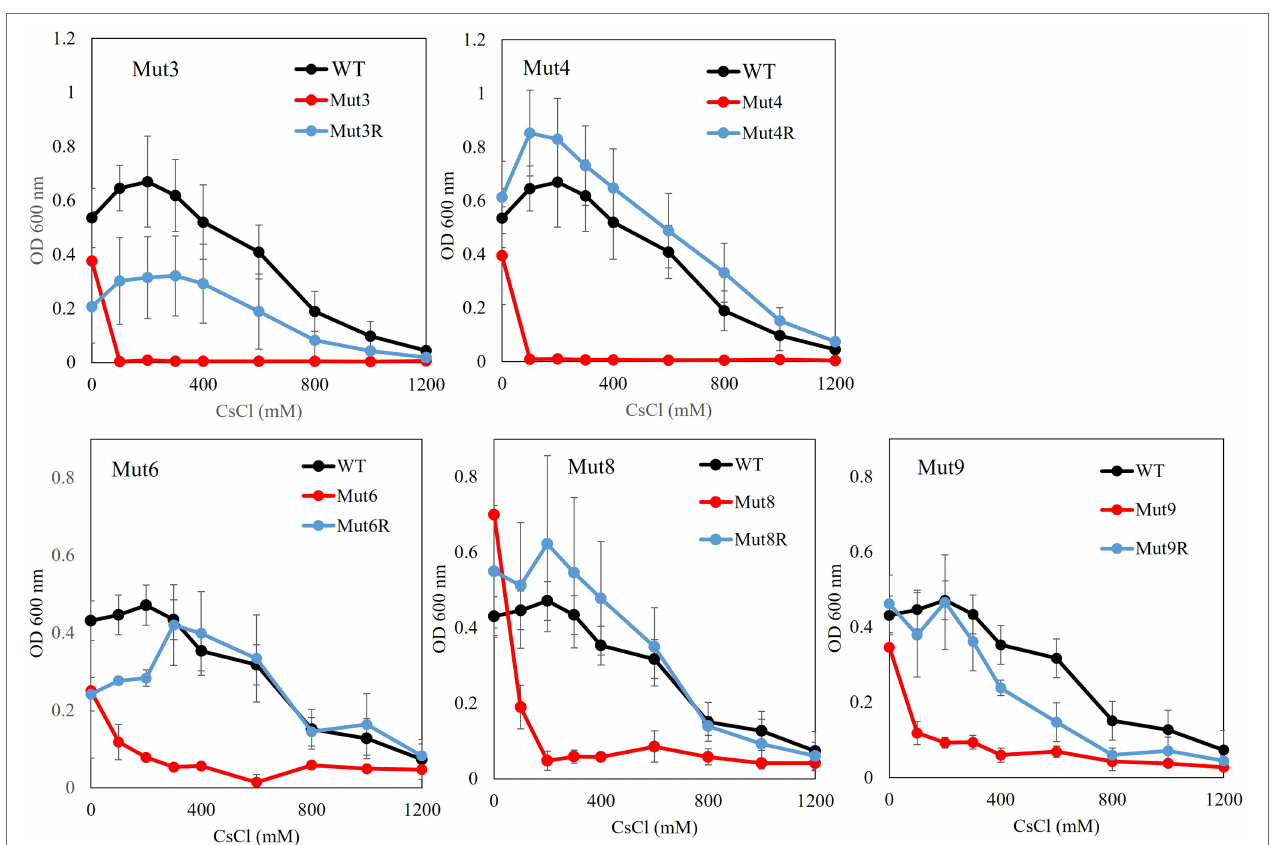
FIGURE 4 | Test to evaluate the Cs + resistance growth of each Cs + -sensitive mutant and its revertant mutants. Colonies of each mutant isolated from a single colony were inoculated into 2 ml NC medium (pH 8.0) and reciprocally shake incubated at 200 rpm at 30 ° C for 18 h. Ten microliters of the preculture were inoculated into 2 ml Tris medium (pH 8.0) with various concentrations of CsCl (100–1,200 mM) and reciprocally shaken at 30 ° C at 200 rpm for 18 h, and the OD 600 was measured. Error bars show the SD of three independent